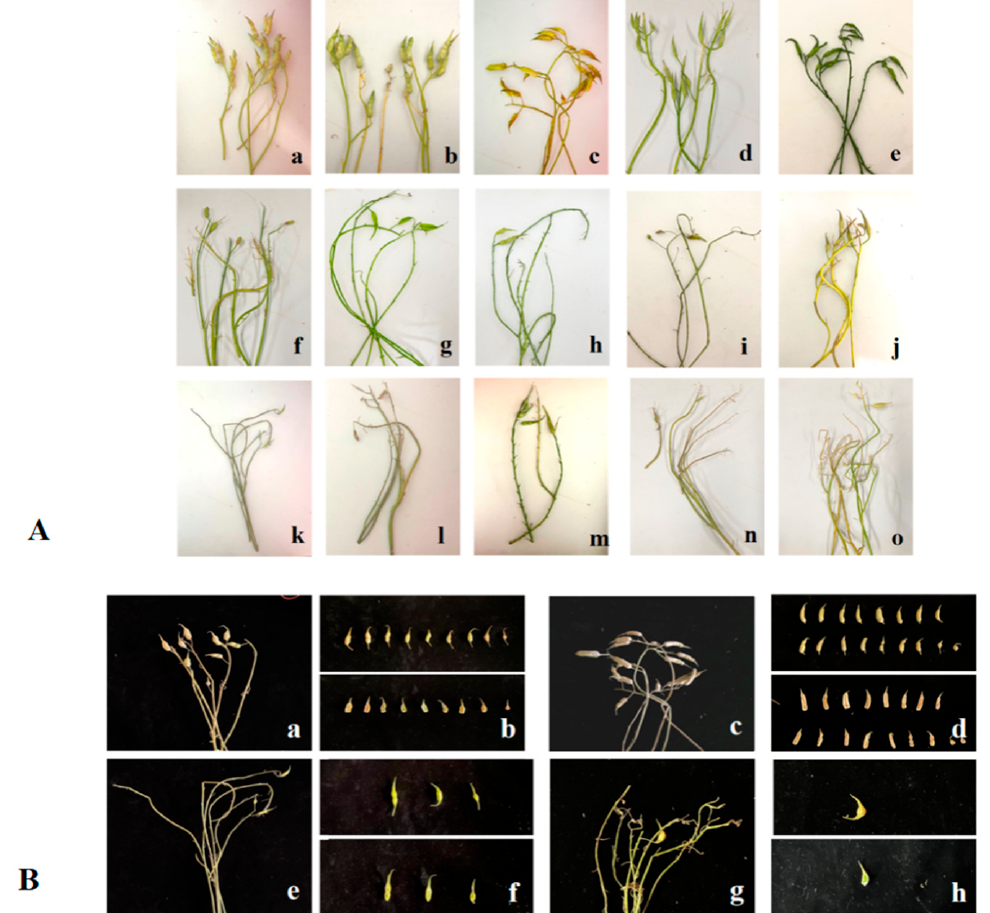
Figure 4. The pod setting and seed setting of different pollination combinations. ( A ). ( a ). NAU-Rs1